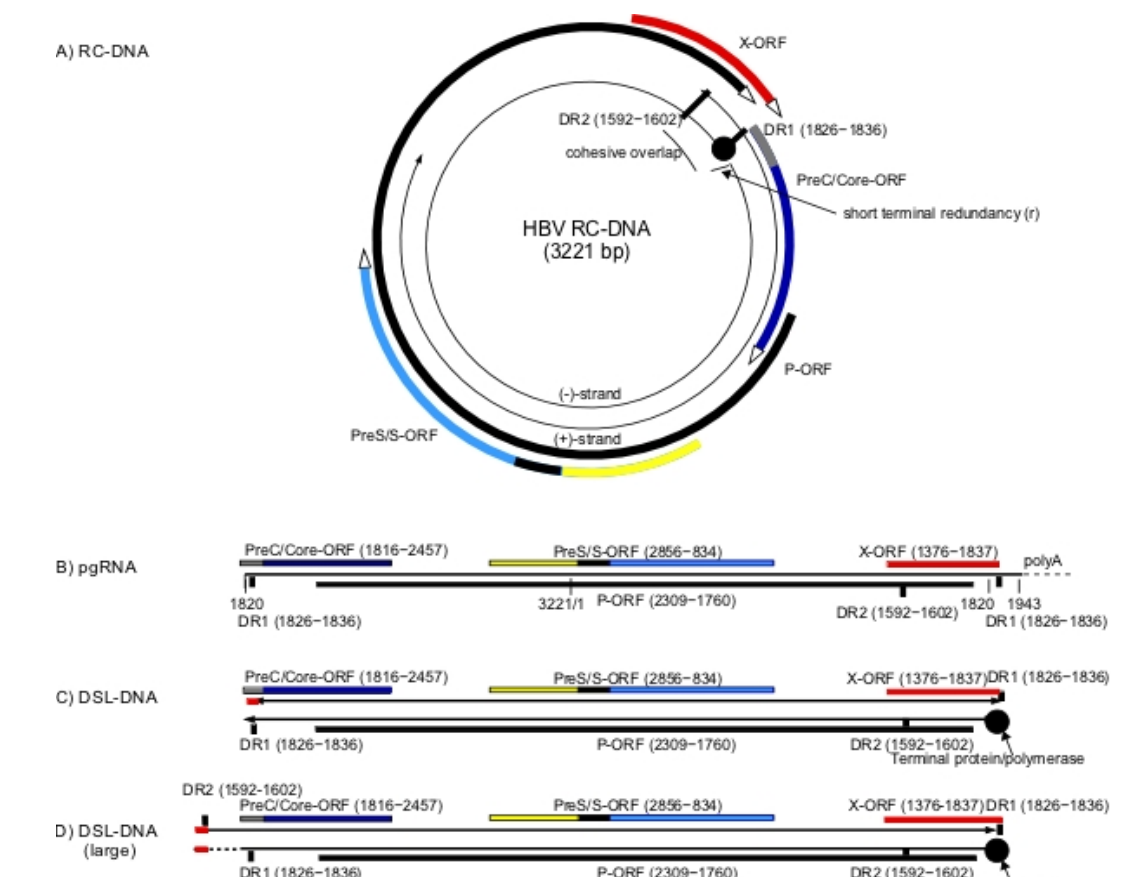
Figure 1. Human hepatitis B virus (HBV) DNA replication intermediates and integration into the chromosomal DNA of hepatocytes: Viral RC-DNA, shown at the top ( A ), is converted to covalently closed circular DNA (CCC-DNA) (not shown) during initiation of infection. All of the virus open reading frames (ORFs) are encoded on the negative strand of the RC-DNA genome as shown and include the polymerase (P-ORF), PreC/Core (C-ORF), PreS/S-ORF and X-ORF. Pre-genomic RNA (pgRNA) ( B ) is transcribed from CCC-DNA and functions as the mRNA for core (nucleocapsid) and polymerase (reverse transcriptase) proteins, both of which are required for viral DNA synthesis. Core protein is also recognized in infected cells as hepatitis B core antigen (HBcAg). An mRNA with extra 5 ′ sequences is the template for the PreC/Core protein that is processed into the secreted hepatitis B e antigen (HBeAg), while sub-genomic mRNAs encode the HBV envelope proteins (HBsAg) and the HBV X protein (HBx). Pre-genomic RNA along with the viral polymerase is packaged in the cytoplasm into viral nucleocapsids comprised of core protein and is reverse transcribed into new viral DNA. RC-DNA ( A ) is the major product of reverse transcription. As discussed in the text, DSL-DNA ( C ) is a minor species formed when the RNA primer for second strand synthesis fails to translocate from DR1 to DR2. DSL-DNA is the usual precursor for HBV DNA integration into chromosomal DNA. A second larger form of DSL-DNA ( D ) is proposed to be formed from RC-DNA during initiation of infection, via strand displacement DNA synthesis through the cohesive overlap region of RC-DNA. As discussed, this larger DSL-DNA species may also be a precursor for integration of HBV DNA into chromosomal DNA.